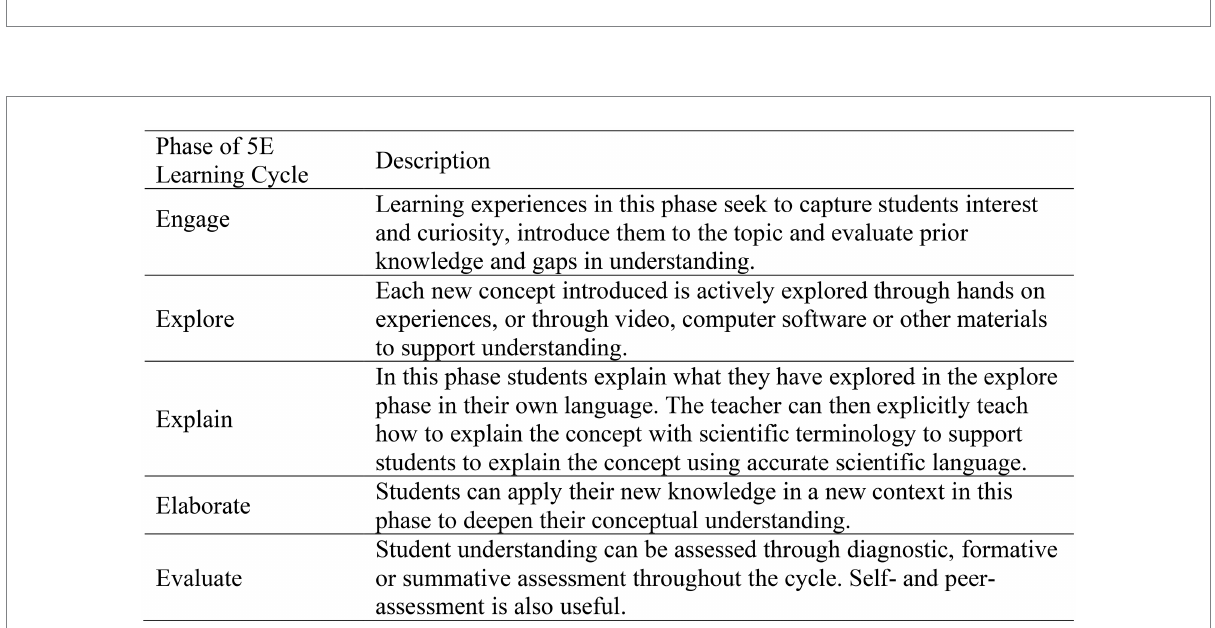
FIGURE 2 Professional learning/intervention sequence of activities and 5E’s phases.